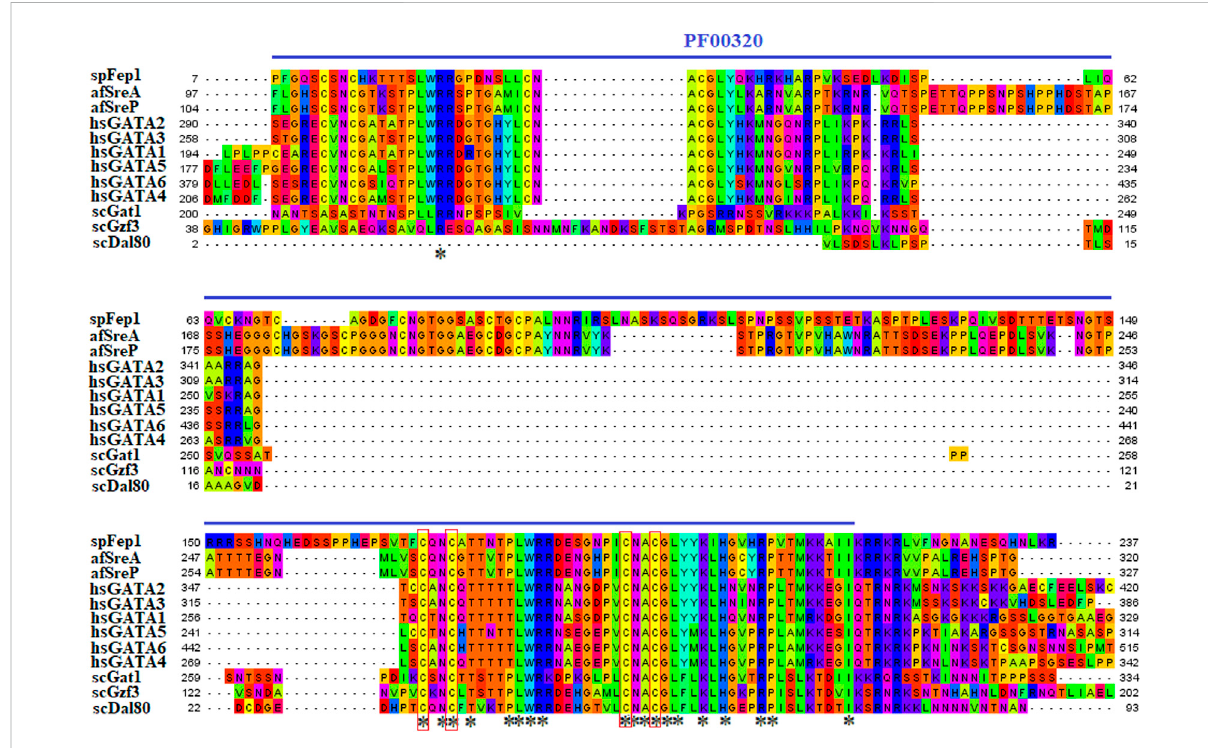
FIGURE 3 Multiple sequence alignment of sequences of the PF00320 domain in spFep1 and its sequence homologs in A. fl avus, S. cerevisiae, and humans using the MEGA_X_10.1.8 software. The domain was identi fi ed by searching the SMART database. The four characteristic Cys residues are boxed while amino acid residues are highlighted according to the biochemical properties of the amino acid